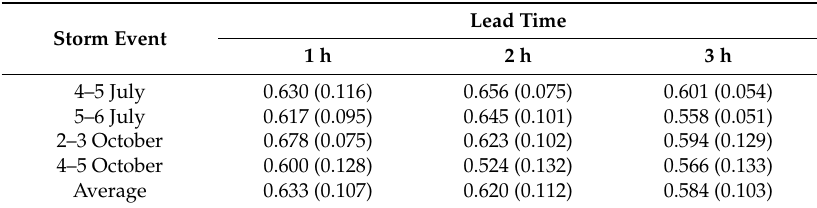
Table 2. Means and standard deviations (within the parenthesis) of pattern correlation estimated for four storm events that occurred in 2016.